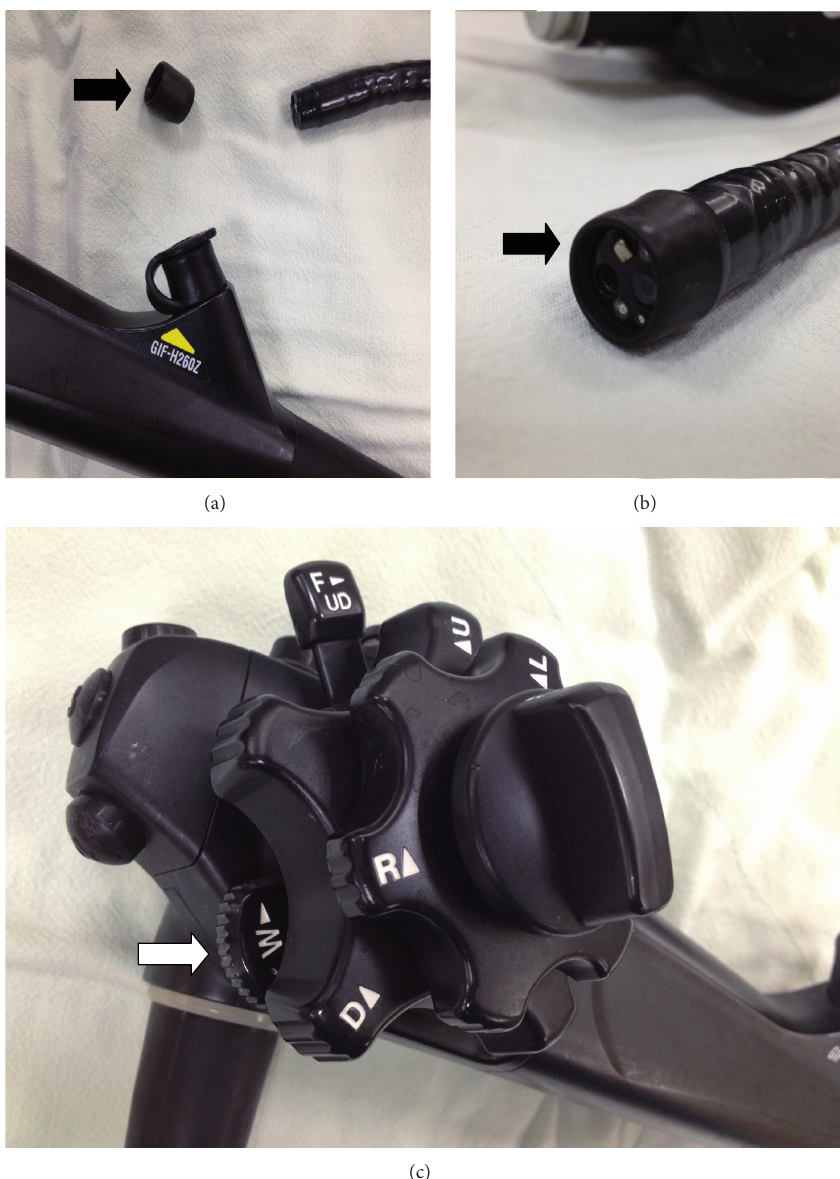
Figure 2: By adjusting a switchover apparatus (white arrow), the magnifying endoscope (GIF-H260Z, Olympus Medical Systems Corp, Tokyo, Japan) with plastic cap-fitted at its end (black arrow) can provide 80-fold zooming images.